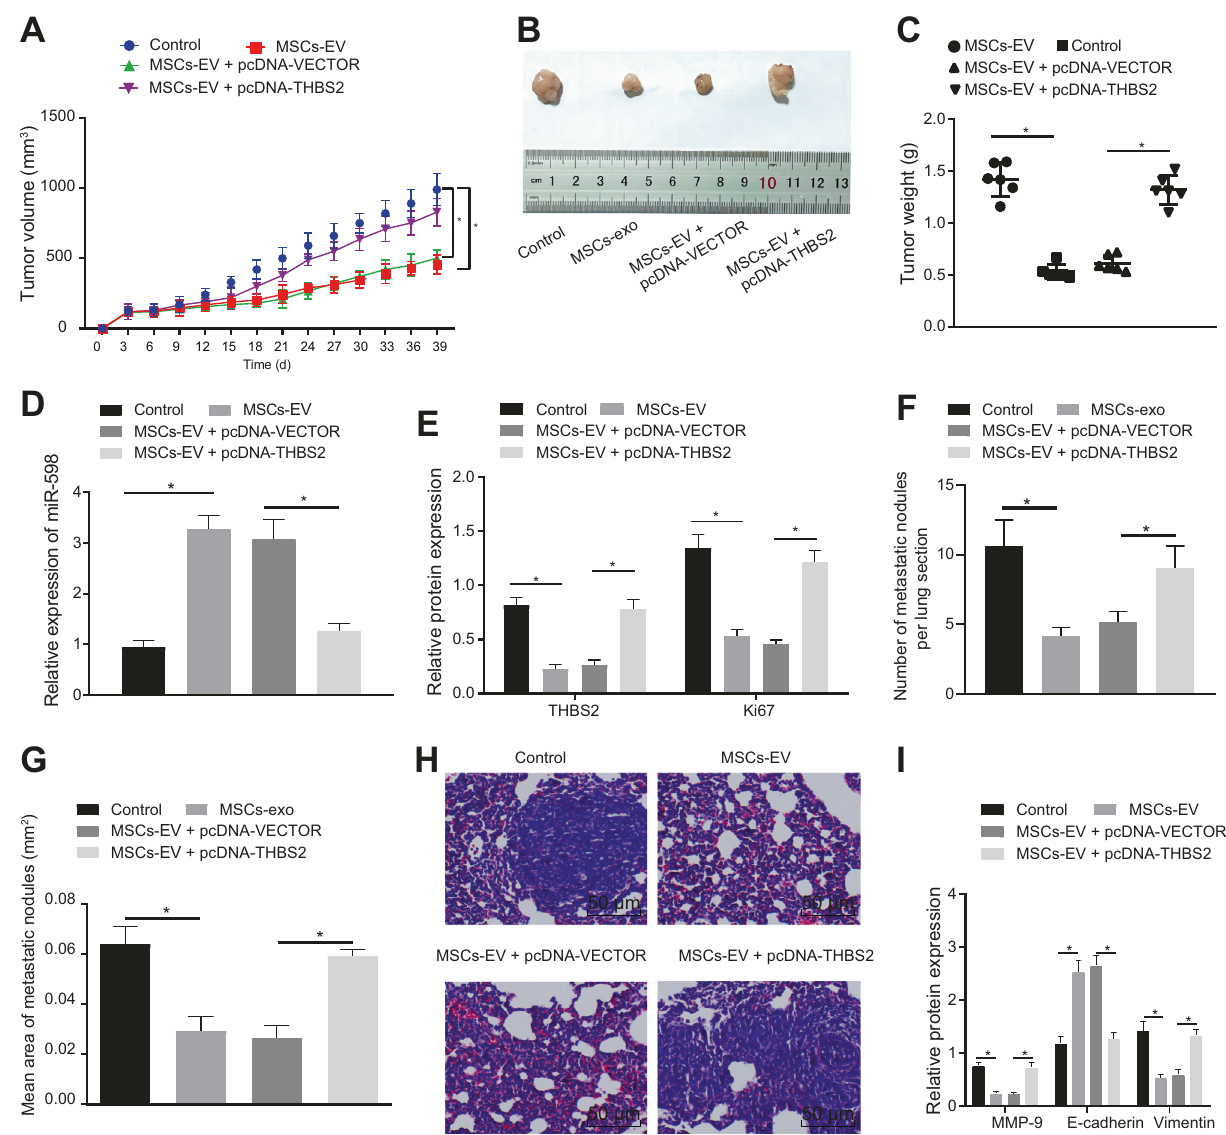
Fig. 8 Effects of EVs-derived miR-598 on tumor growth and metastasis of NSCLC in vivo by targeting THBS2. A Tumor volume in the nude mice after different treatments. B Representative white-light images of tumors after different treatment. C Tumor weight in the nude mice after different treatment. D Expression of miR-598 in tumors of the nude mice after different treatments by RT-qPCR. E Protein levels of THNS2 and Ki67 in tumors of the nude mice measured by Western blot analysis. F Number of metastatic nodules in the lungs of nude mice. G Area of metastatic nodules in the lungs of nude mice. H Morphology of metastatic nodules in the lungs of nude mice observed by H&E staining. I Protein levels of E-cadherin, Vimentin, and MMP-9 in metastatic nodules in the lungs of nude mice by Western blot analysis. n = 6 in each group in the subcutaneous tumorigenesis experiments, n = 15 in each group in the pulmonary metastasis experiments. * p < 0.05 between two groups. Data among multiple groups were compared by ANOVA with Tukey ’ s post hoc test. Comparison among groups at different time points was performed using repeated measures of ANOVA with Bonferroni ’ s post hoc The EVs secreted by MSCs can carry and deliver DNA, RNA, and protein cargoes to regulate cellular signaling pathways in target cells [25]. EVs are nanospheres with a bilayer membrane that transport miRs cargoes and can thus overcome some of the limitations of lipid and polymeric miR delivery systems [26]. Of note, MSCs-EVs are emerging as important carriers of miRNAs for the ef fi cient treatment of various diseases [27], speci fi cally lung cancer [28]. In this investigation, we discovered that miR-598 was highly expressed in MSCs-EVs; after internalization of the miR-598-